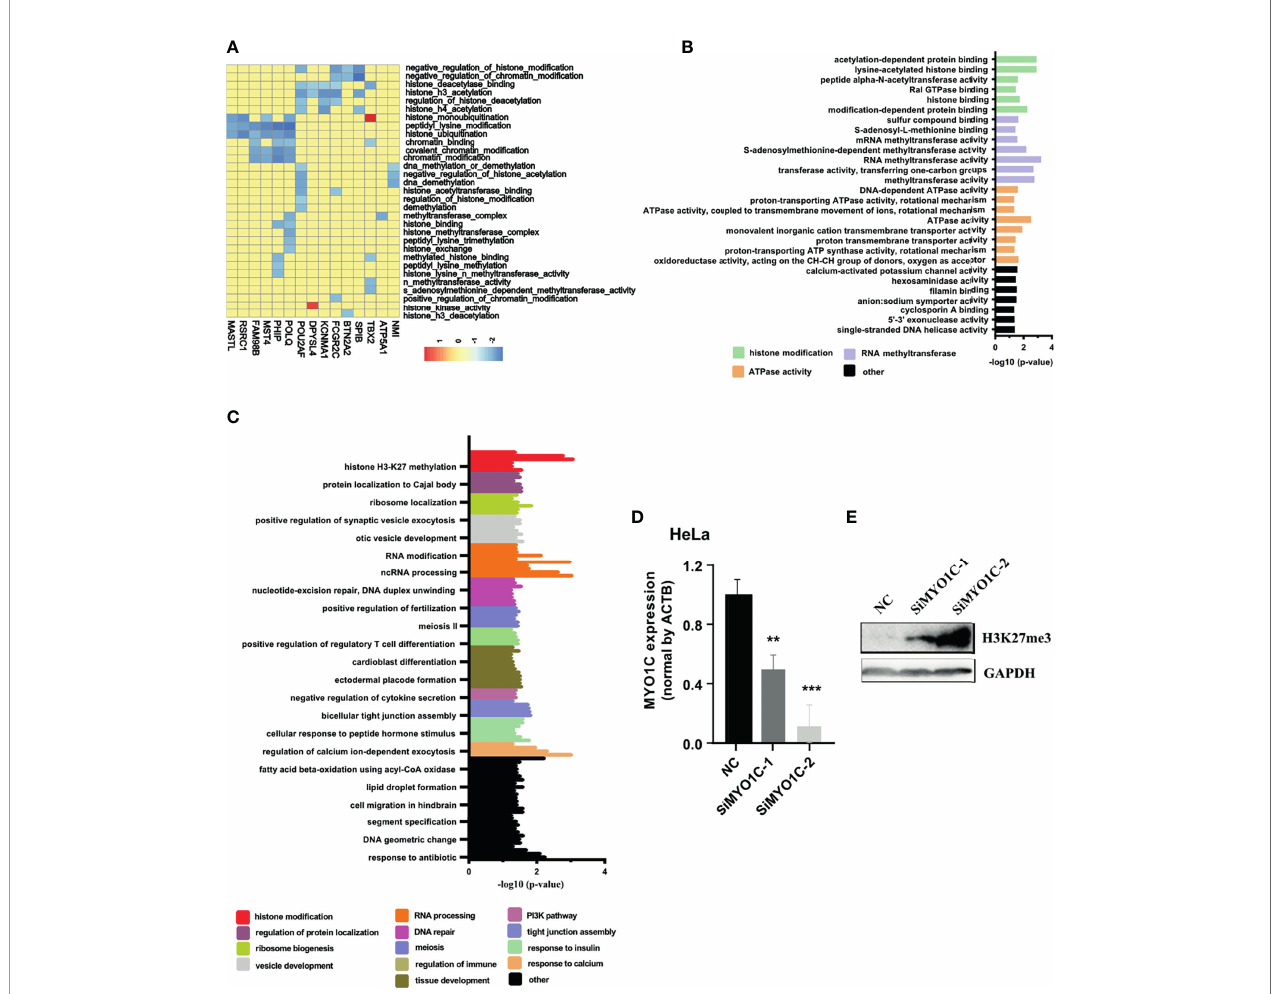
FIGURE 2 | GSEA and GO con fi rming that PRC2-bound RNAs are associated with histone modi fi cation. (A) Heatmap showing the PRC2-bound RNAs involved in histone modi fi cation in GSEA. The enrichment score (ES) is shown as color intensity. Blue indicates PRC2-bound RNAs negative relevant to histone modi fi cation, and the red indicates the opposite. (B, C) GO analysis of the enrichment items of PRC2-bound transcripts in sub-ontologies of biological processes (B) and molecular function (C) . (D, E) qRT-PCR detecting the mRNA expression level of MYO1C (D) and Western blotting analyzing the modi fi cation level of H3K27me3 (E) in HeLa cells transfected with SiMYO1Cs for 48 h (negative control (NC)). Data are represented as means ± SD, ** p < 0.01, *** p < 0.001, unpaired, two-tailed, Student ’ s t -test. GSEA, gene set enrichment analysis; GO, gene ontology; PRC2, polycomb repressive complex